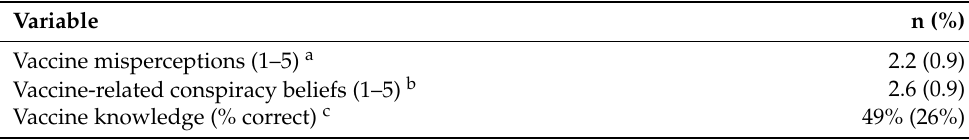
Table 4. Mean scores (SD) for misperceptions, knowledge, conspiracy.